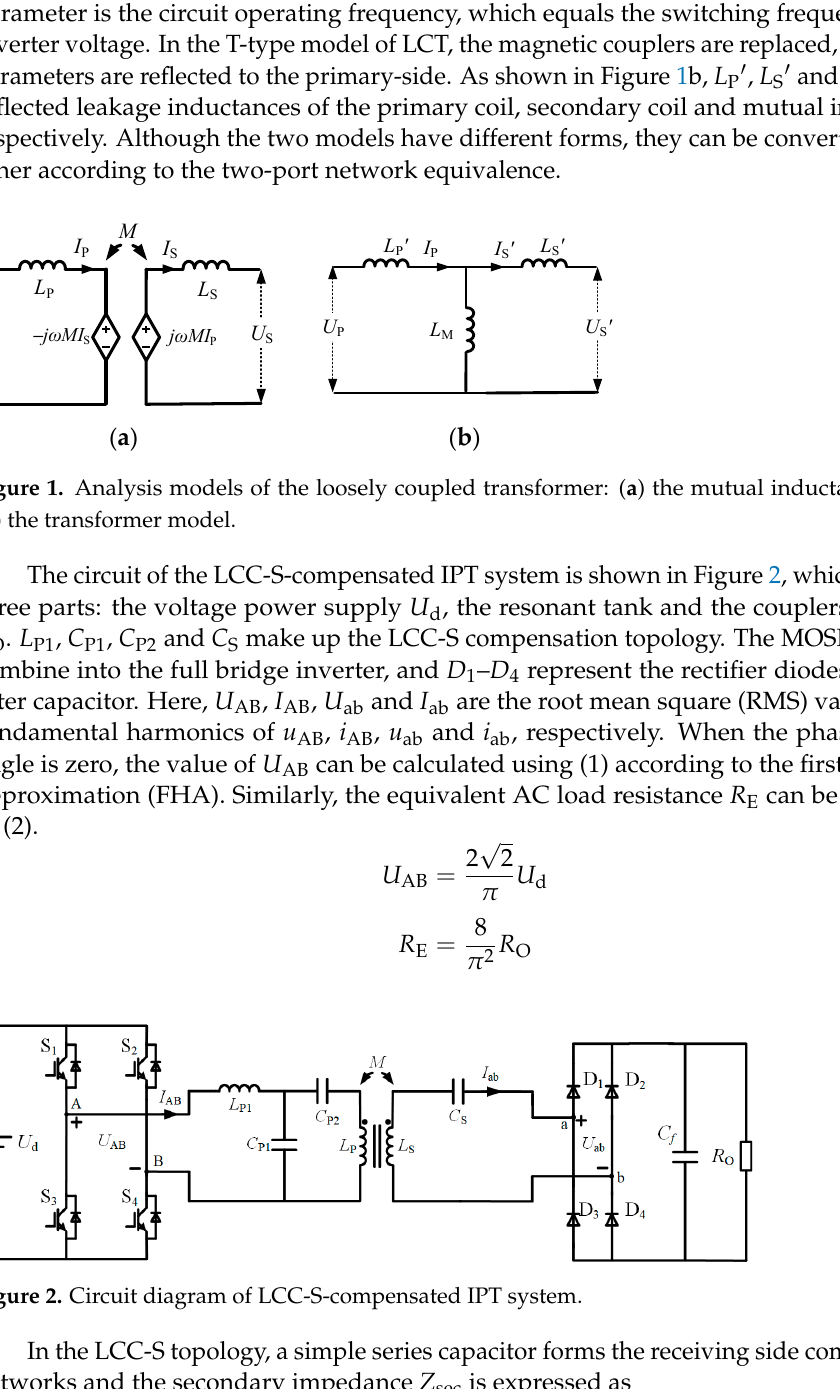
Figure 2. Circuit diagram of LCC-S-compensated IPT system.